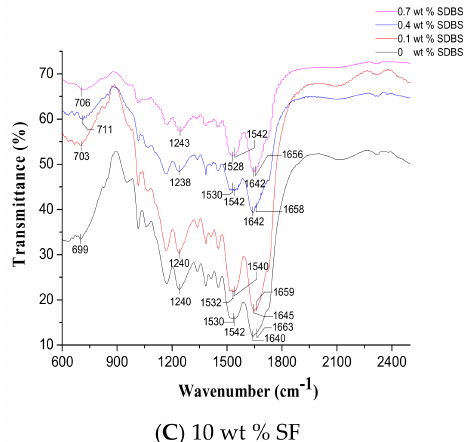
Figure 9. FTIR spectra of NFMs with SF concentrations of ( A ) 6 wt %; ( B ) 8 wt % and ( C ) 10 wt %, respectively. (Gas flow volume: 50 m 3 /h).